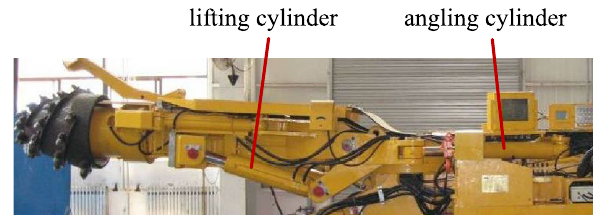
Fig. 5 Schematic diagram of vertical swing process of the cutting